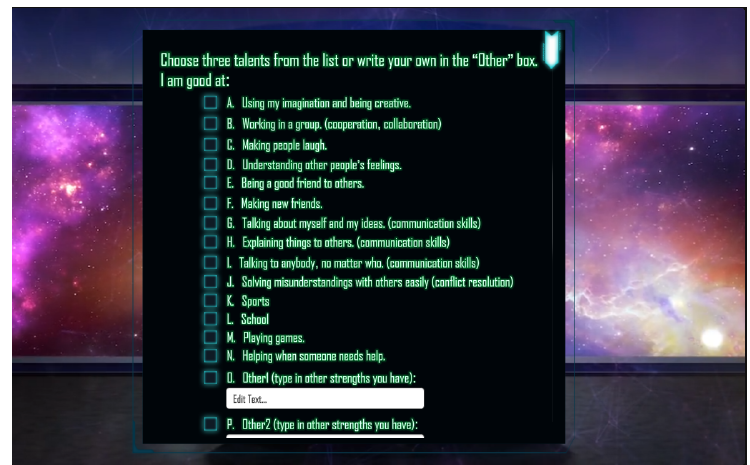
Figure A1. Personal strengths activity.